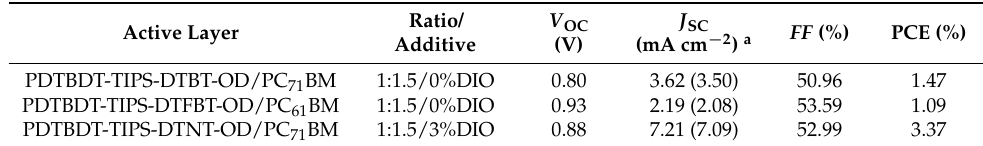
Figure 7. The optimized current density–voltage ( J – V ) curves ( a ) and external quantum efficiency (EQE) spectra ( b ) of the optimized devices. Table 2. The optimized photovoltaic (PV) parameters of polymer solar cells (PSCs) based on the studied copolymers.